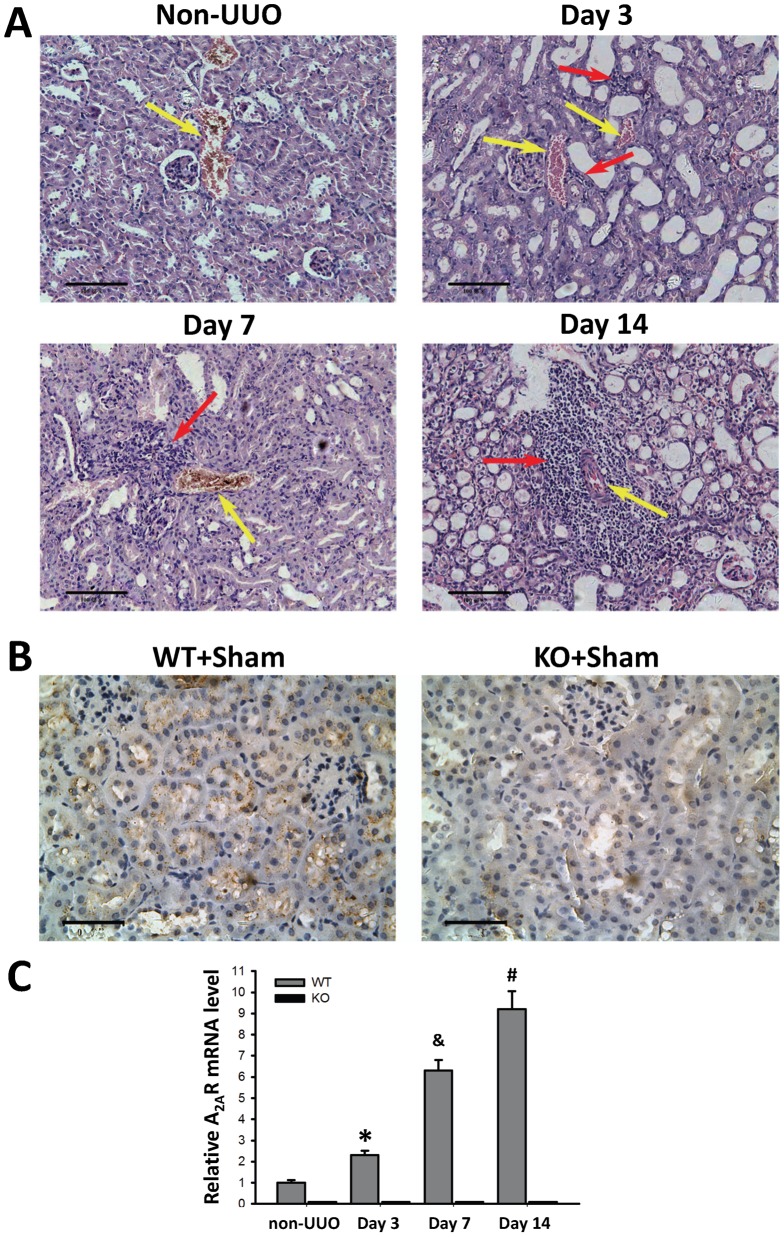
UUO-induced renal infiltration of leukocytes and increased mRNA expression of A2AR.(A) Representative H&E staining of renal tissue from mice subjected to UUO model. The infiltrations of leukocytes were observed around renal vessels (yellow arrow pointed), which were increased in a time-dependent manner, from day 0 through day 14 post-UUO. The red arrow is pointed at the inflammatory cells. Scale bar = 100 µm, 200×. (B) A2AR immunochemistry data showed positive stained renal tubular epithelial cells in wild-type mice (WT+Sham), but not in A2AR knockout mice (KO+Sham). Scale bar = 50 µm, 400x. (C) Demonstration of the renal levels of A2AR mRNA in non-UUO mice and at day 3, 7 and 14 post-UUO in mice. Data are mean ± SD. n = 10 per time point. * P<0.05, vs non-UUO WT mice; & P<0.05; vs WT day 3; # P<0.05, vs WT day 7, accordingly.